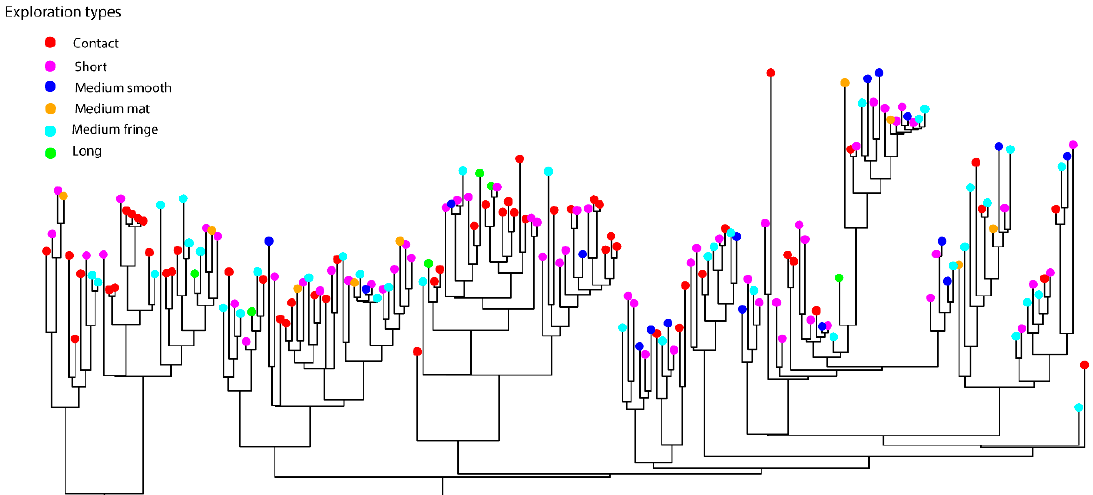
Figure 5. The hybrid phylogenetic tree displaying the distribution of the exploration types (Contact, short, medium smooth, medium fringe and long).